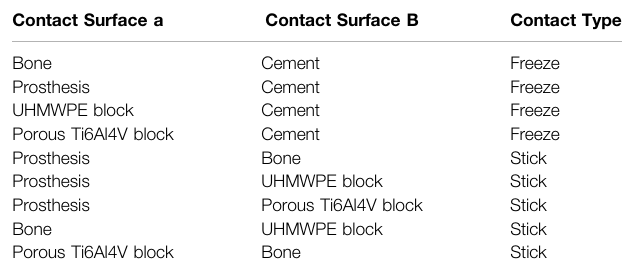
TABLE 2 | Material properties of the components. TABLE 3 | Contact types between